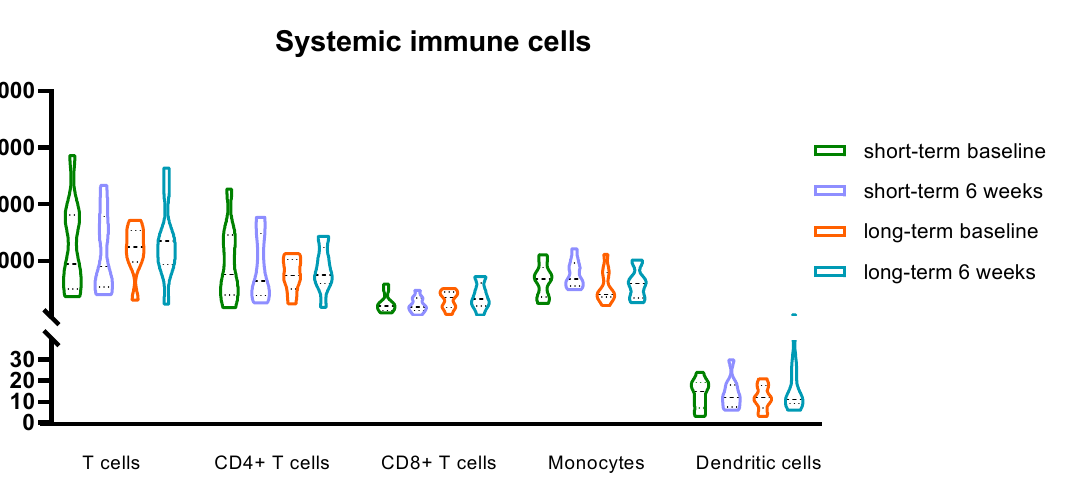
Figure 3. Systemic immune cells in short-term survivors ( n = 9) versus long-term survivors ( n = 9). All p -values ≥ 0.05 using a paired sample t -test.